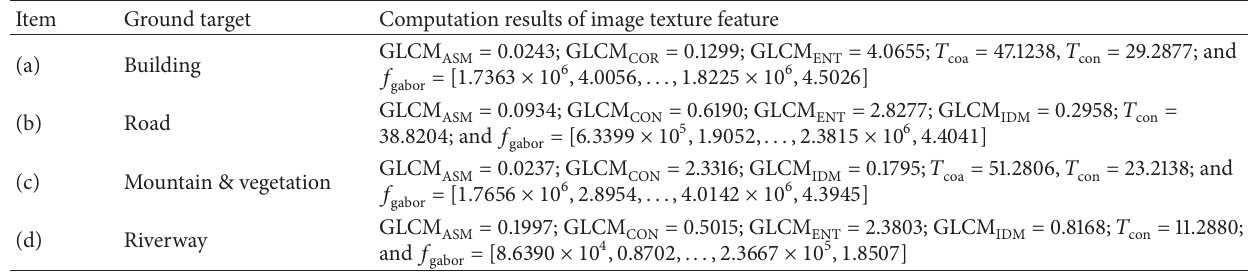
Table 4: The image texture feature computation results of Figure 5.